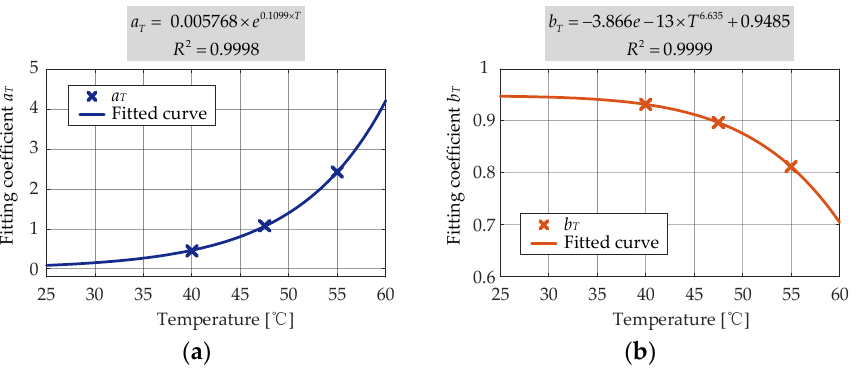
Figure 9. The relationship between the curve fitting coefficients and the corresponding storage temperature. ( a ) Exponential relationship between a T and T , ( b ) Power relationship between b T and T .